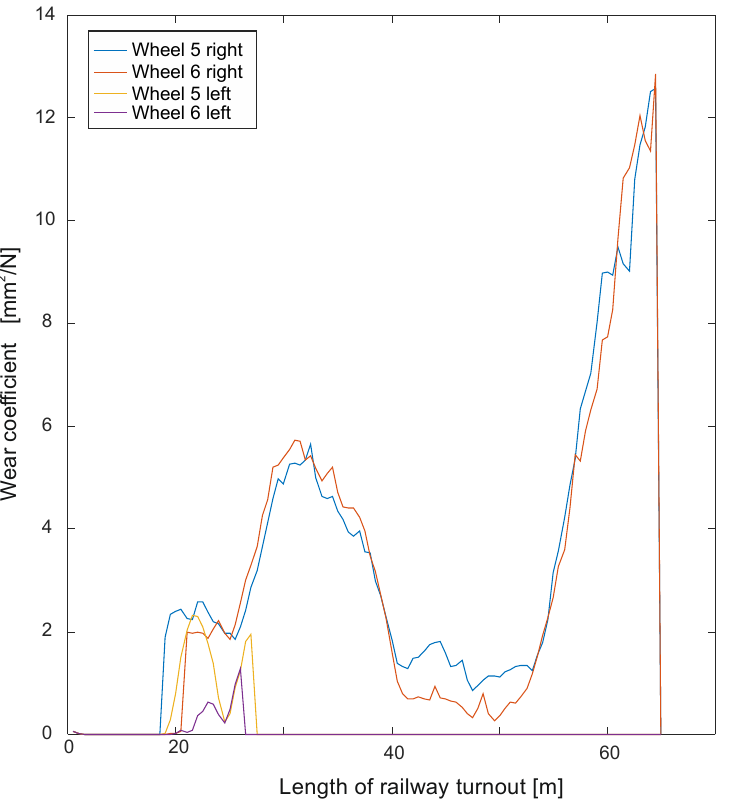
Figure 36. Wear coefficient obtained for a straight track at 350 km/h with a turnout.